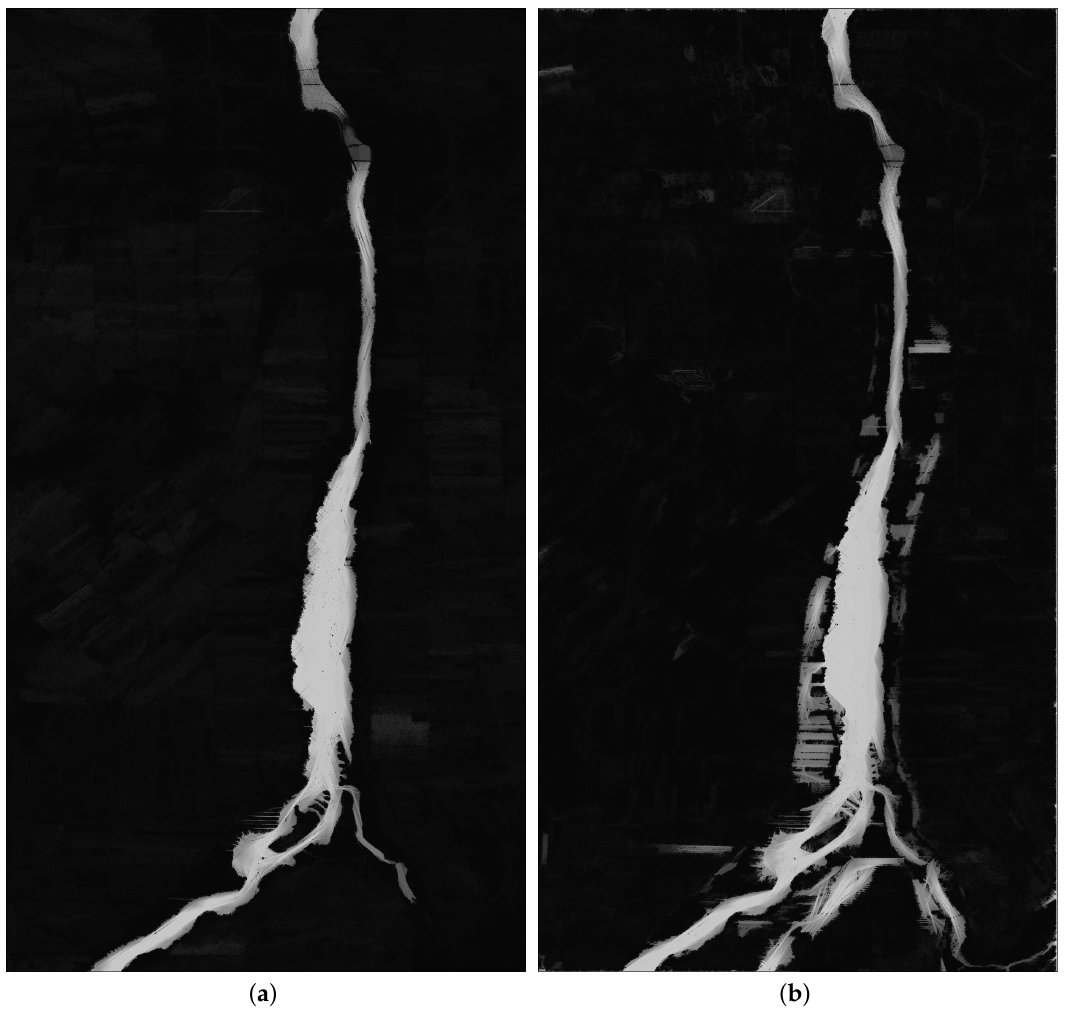
Figure 5. Result of the path-opening application (site 1). ( a ) Result of the path-opening applied to the pre-flooding image ( L min = 100); ( b ) Result of the path-opening applied to the post-flooding image ( L min =